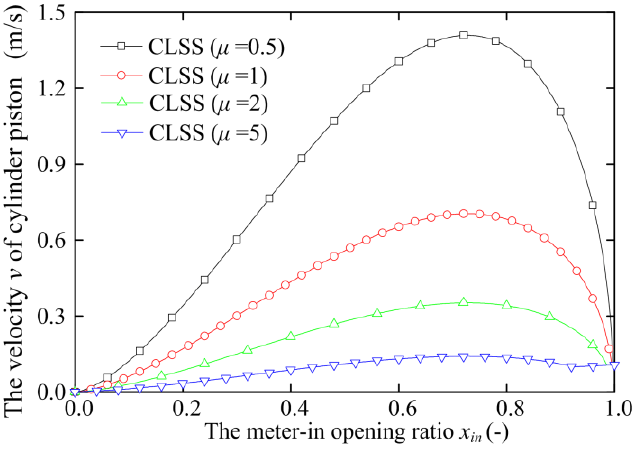
Figure 16. The flow rate Q b of the cylinder rod chamber of CLSS with extension working mode.